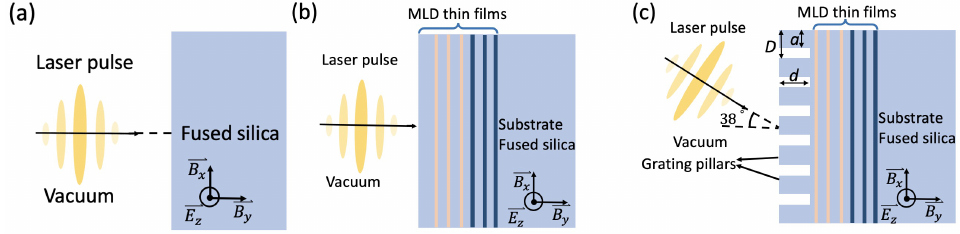
Figure 1. Schematics of simulation model. ( a ) Bulk fused silica; ( b ) MLD mirror; ( c ) MLD grating. D is the grating period. a / D is the duty cycle. d is the etch depth.